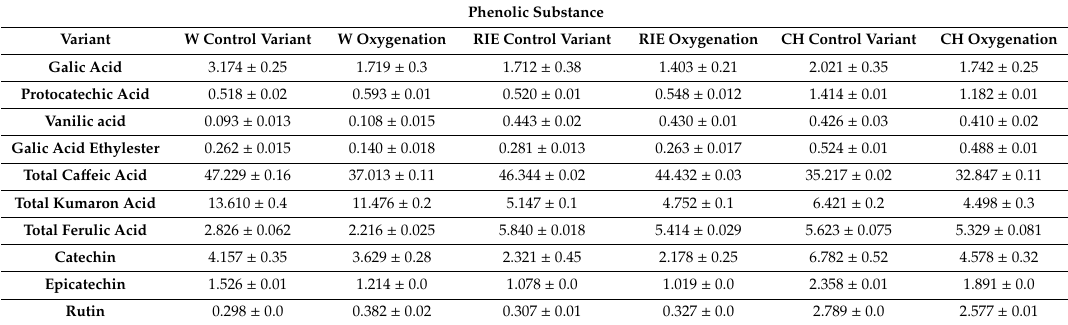
Table 6. Content of 10 monitored substances in mg · L − 1 from individual variants in 2016 with the standard deviations.